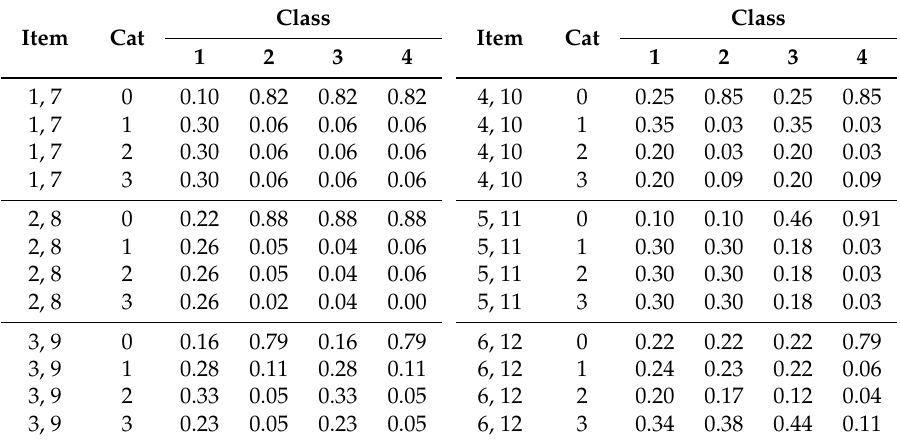
Table 5. Data illustration polytomous data: true item response probabilities p ic .